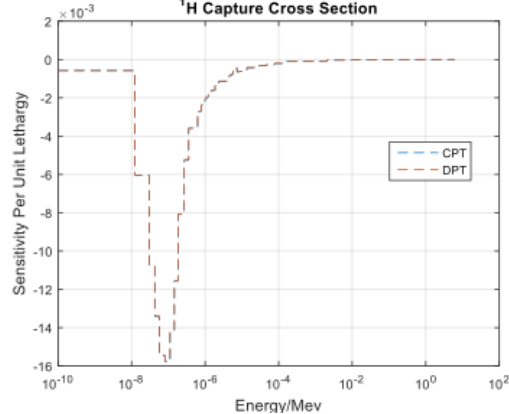
Figure 2. The sensitivity per unit lethargy of k to the 1 H capture cross